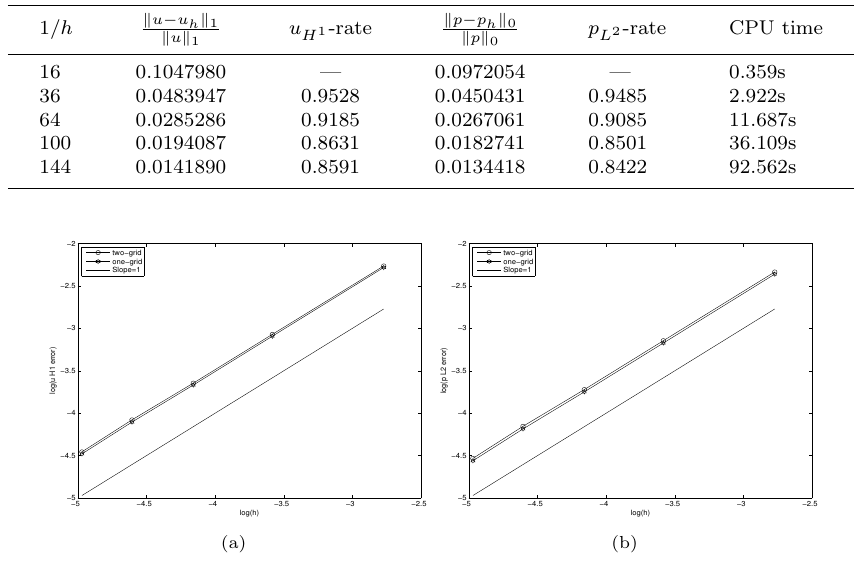
Figure 2. Convergence analysis using one- and two-grid methods for ν = 1. (a) H 1 error for the velocity; (b) L 2 error for the